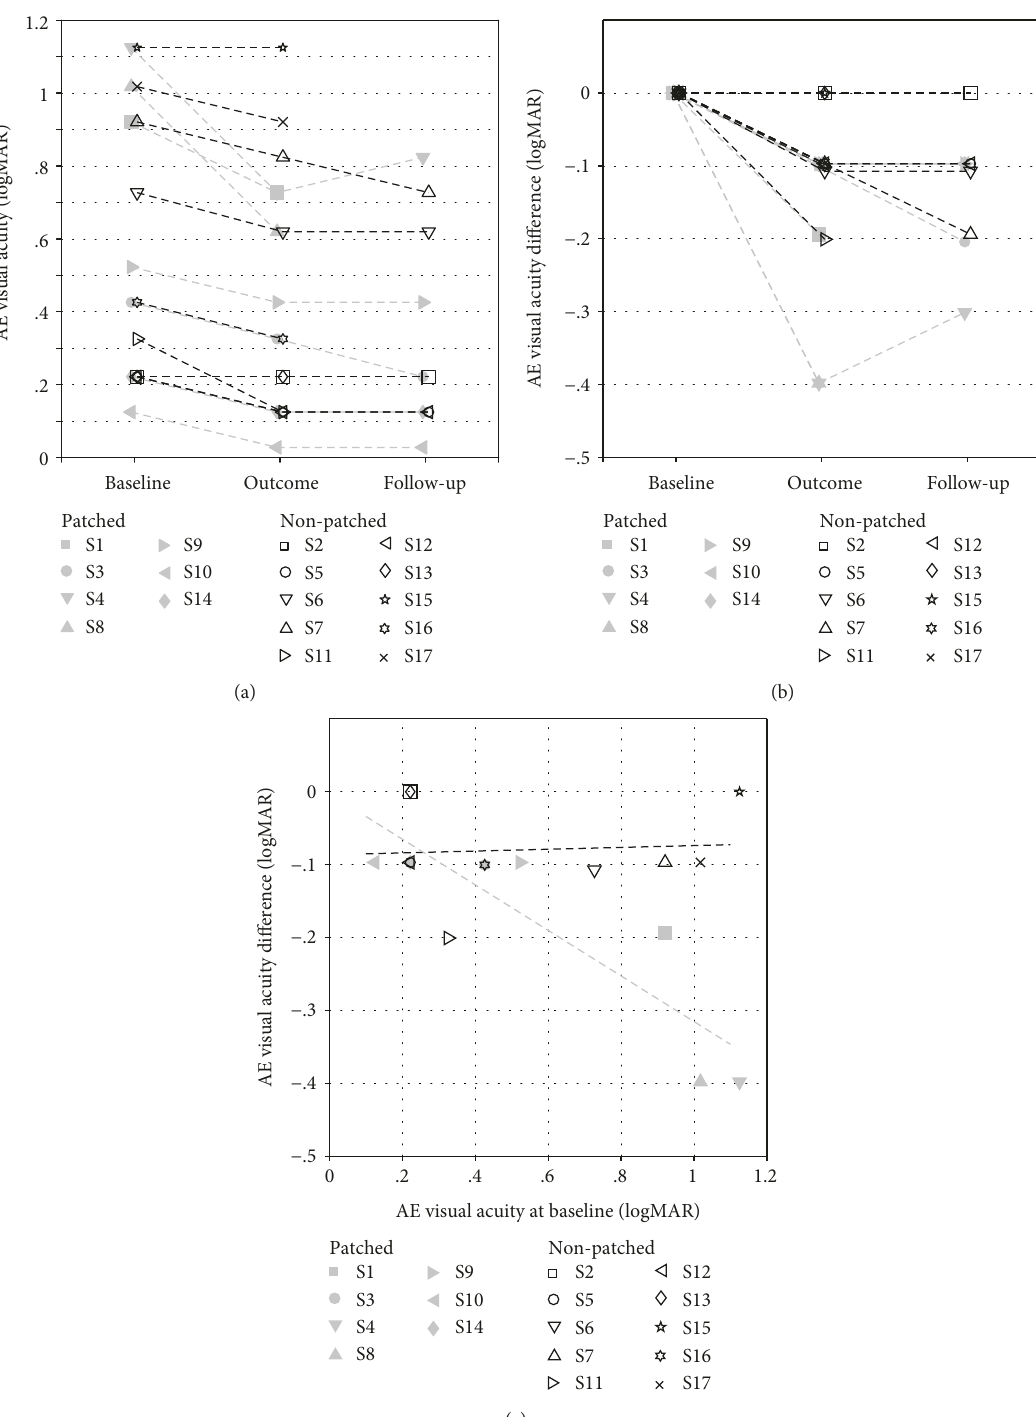
Figure 3: Visual acuity improvement. (a) Visual acuity of the amblyopic eye (AE) of the participants reported at baseline, at the outcome of the training, and at the follow-up control one month later. (b) Visual acuity di ff erence from the baseline of the amblyopic eye. (c) Visual acuity di ff erence from baseline as a function of the initial acuity of the amblyopic eye. Participants from the patched group are indicated with fi lled grey symbols, and participants of the nonpatched group with open black symbols. Dashed lines represent linear